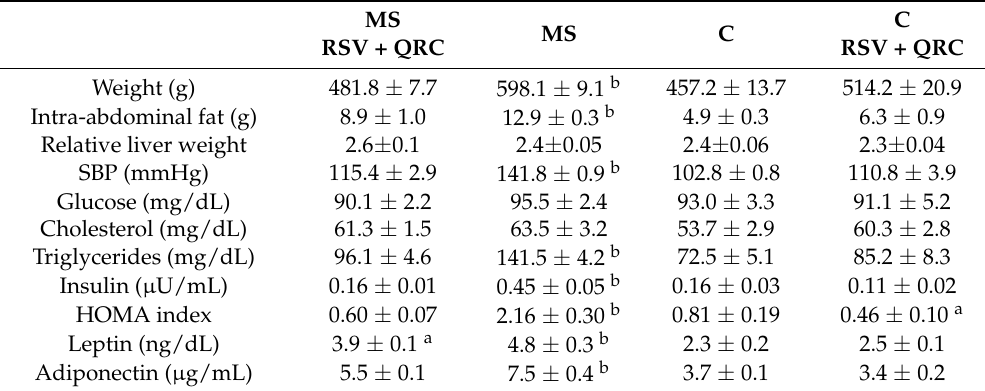
Table 1. General characteristics and serum biochemical in experimental groups.